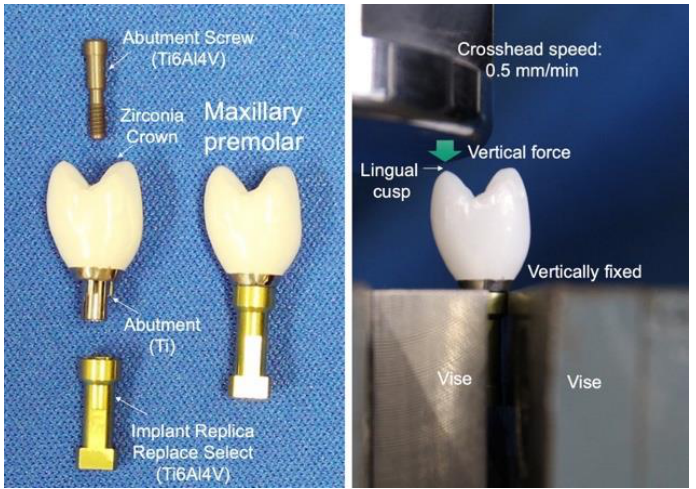
Figure 15. Fracture test specimen of monolithic zirconia crown on a titanium abutment ( left ) and test configuration ( right ).